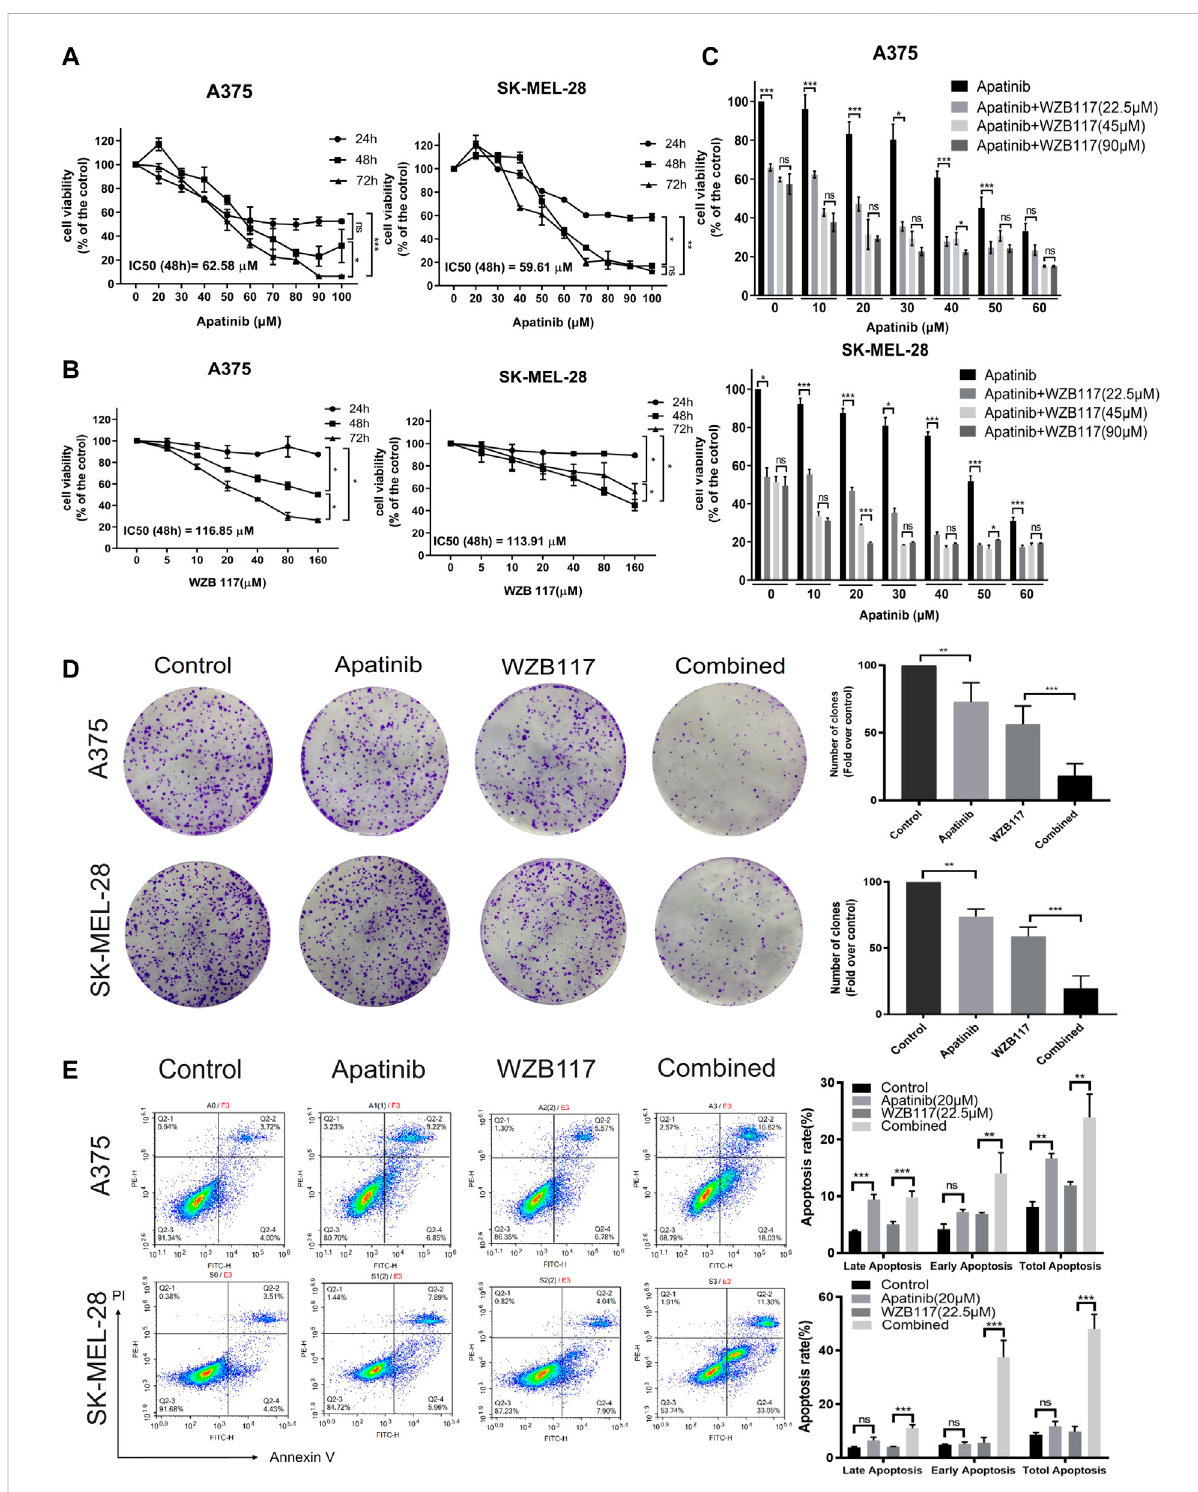
FIGURE 1 ApatinibcombinedwithWZB117showedsynergisticcellproliferationinhibitoryeffectsinA375andSK-MEL-28cells. (A) Dose-responsecurvesofboth cellswhentreatedwitharangeofconcentrationsofapatinib. (B) Dose-responsecurvesofbothcellswastreatedwitharangeconcentrationofWZB117. (C) Cell viability of bothcells whentreated with arange concentrationof apatinib combined with different concentrations of WZB117 for 48 h. (D) Apatinib and WZB117 inhibit colony formation. The images of colony formation are displayed in the left panels, and quantitative results are displayed in the right panels.Quantitativedataarepresentedasthemean±SDof fi veindependentexperiments. (E) ApatinibandWZB117inducecellapoptosis.Therepresentative dot plots are shown in the left panels, and quantitative results are shown in the right panels. Quantitative data are presented as the mean ± SD of three independent experiments. “ * ” means p < 0.05, “ ** ” means p < 0.01, and “ *** ” means p <